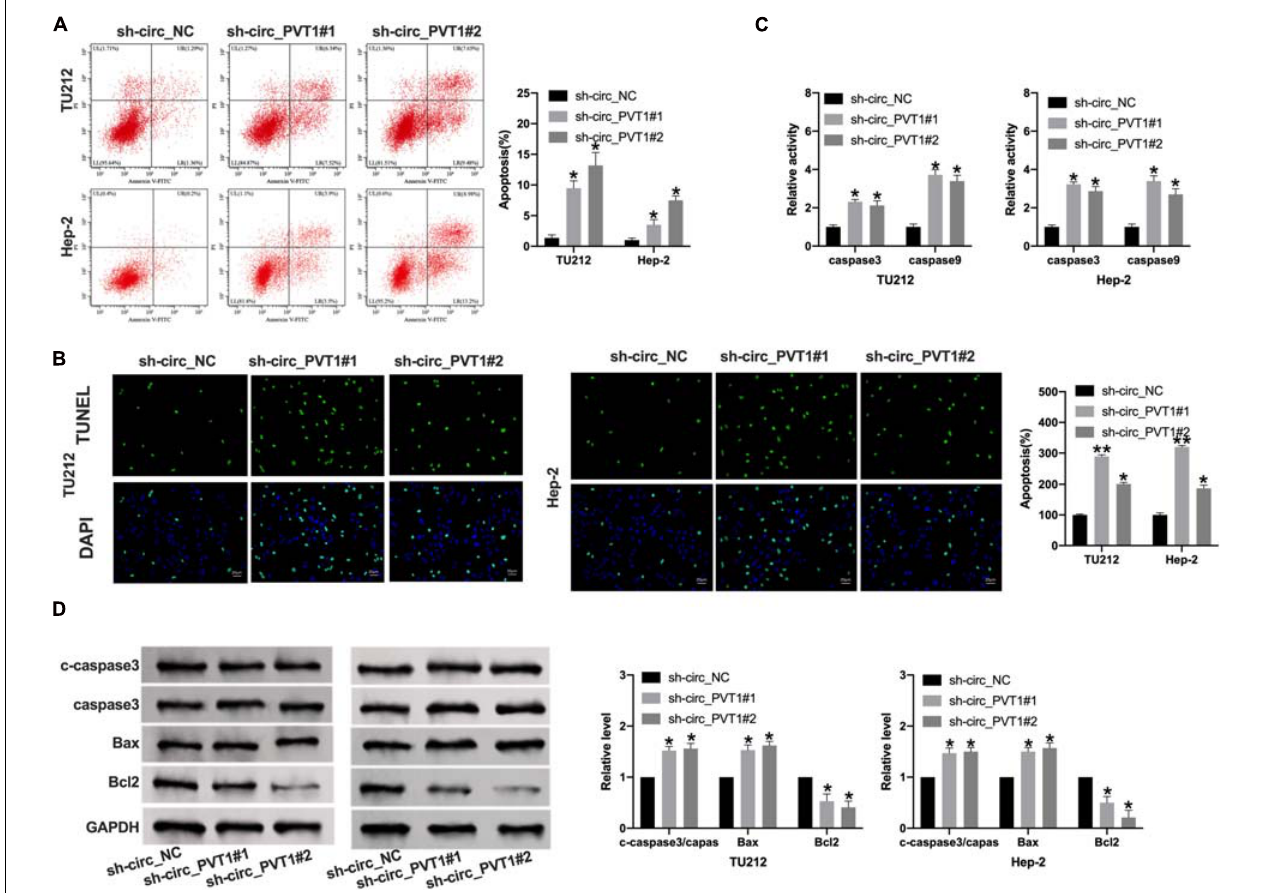
FIGURE 3 | Circ_PVT1 blockage induces apoptosis in LC cells. (A) Flow cytometry was performed to detect the apoptosis rate. * P < 0.05, n = 4. (B) TUNEL staining. * P < 0.05, ** P < 0.01, n = 4. (C) The caspase 3 and caspase 9 activity was determined by ELISA. * P < 0.05, n = 4. (D) The protein level